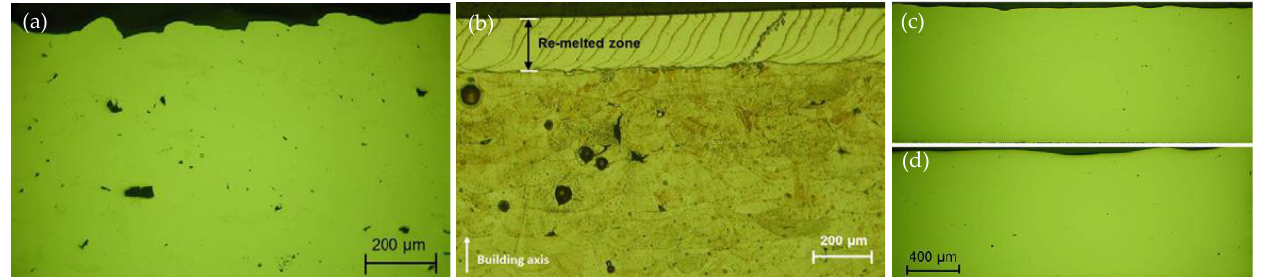
Figure 11. Microstructure of the LPBF-printed 316L stainless steel: ( a ) The as-printed part shows a high surface roughness; ( b ) the as-printed part with remelting of the top layer; ( c ) One remelting scan reduces porosity to 0.036%; ( d ) Three remelting scans produce 0.043% porosity. Reproduced with permission from Elsevier [37].